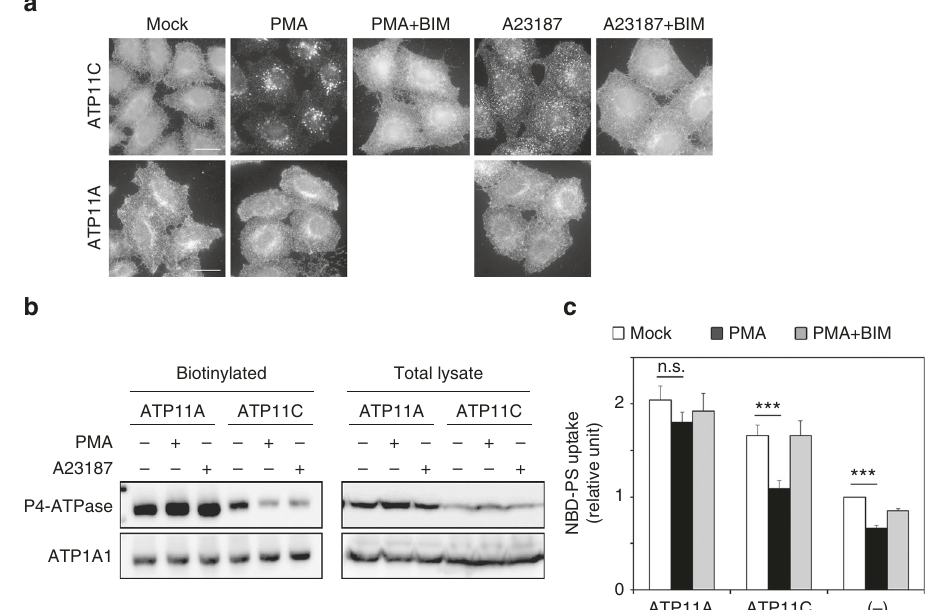
Fig. 1 ATP11C is endocytosed by treatment with phorbol 12-myristate 13-acetate (PMA) and increasing cytosolic Ca 2+ . a HeLa cells stably expressing C-terminally HA-tagged ATP11A, and ATP11C were treated for 15 min at 37 °C with vehicle alone (Mock); with either 400 nM of PMA (PMA) or PMA and 2 μ M of BIM-1 (PMA + BIM); or with 1 μ M A23187 in the presence of either 1.8 mM of CaCl 2 (A23187) or 1.8 mM CaCl 2 and 2 μ M BIM-1 (A23187 + BIM). The cells were fi xed and immunostained with anti-HA antibody, followed by Cy3-conjugated anti-rat secondary antibody. See Supplementary Fig. 1 and Supplementary Movie 1. b Cell-surface expression levels of ATP11A and ATP11C following treatment with PMA or A23187 and CaCl 2 were analyzed after surface biotinylation. Proteins precipitated with streptavidin-agarose beads were subjected to immunoblot analysis (left panels, biotinylated). 15% of the input of the biotinylation reaction was loaded in each lane (right panels, total lysate). Expression of ATP11A and ATP11C proteins was analyzed by immunoblotting with anti-HA and anti-ATP1A1 (as an internal control) antibodies. c HeLa cells stably expressing HA-tagged ATP11A and ATP11C, and (gray bars) for 15 min. The cells were then washed with fl ippase assay buffer and incubated with NBD-PS at 15 °C for 5 min. After extraction with